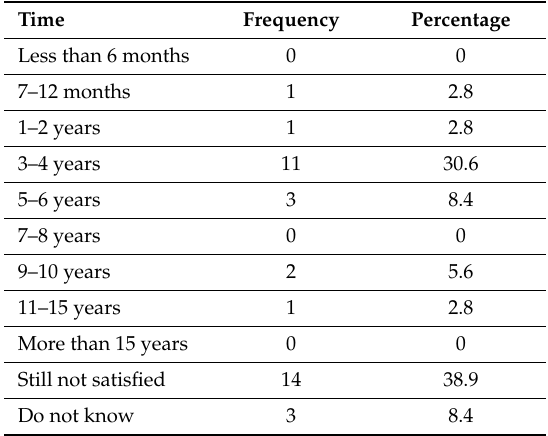
Table 20. Time to reach satisfaction (N = 36).